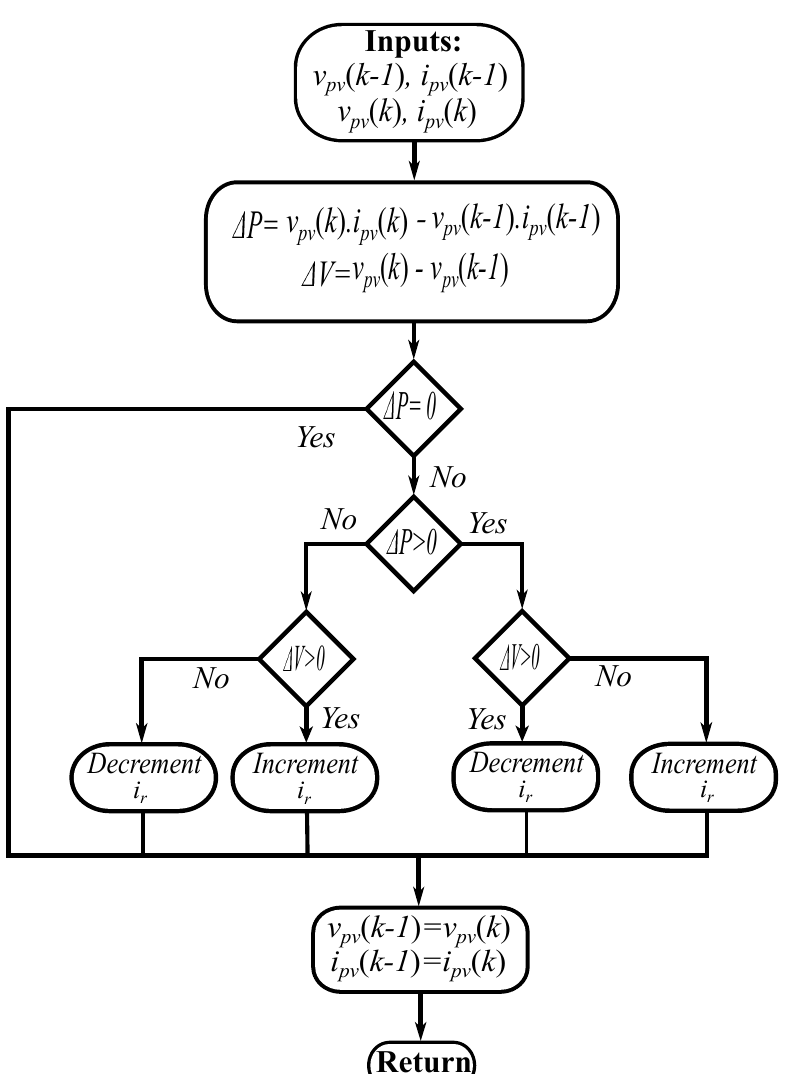
Figure 8. Traditional P&O algorithm for